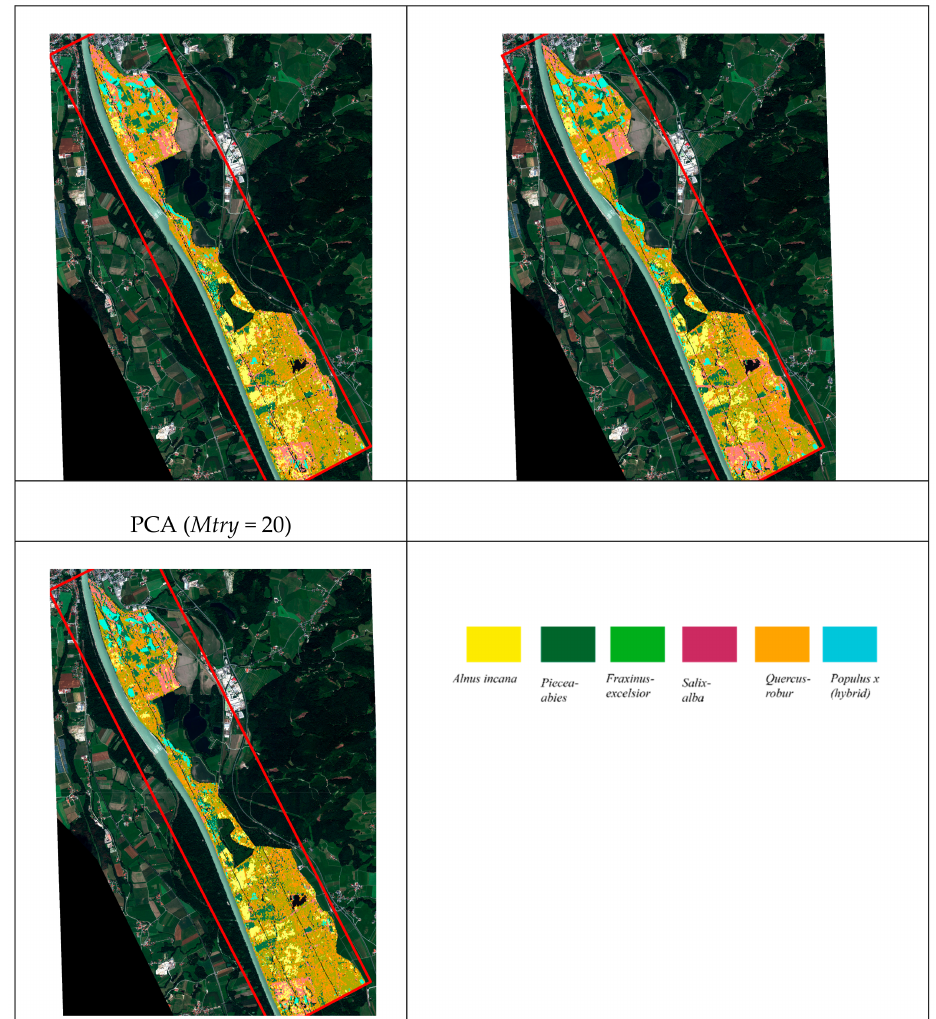
Figure 8. Overall classification results using the APEX (original bands with Mtry = 268 and Mtry = 17), MNF, ICA, and PCA transformations.